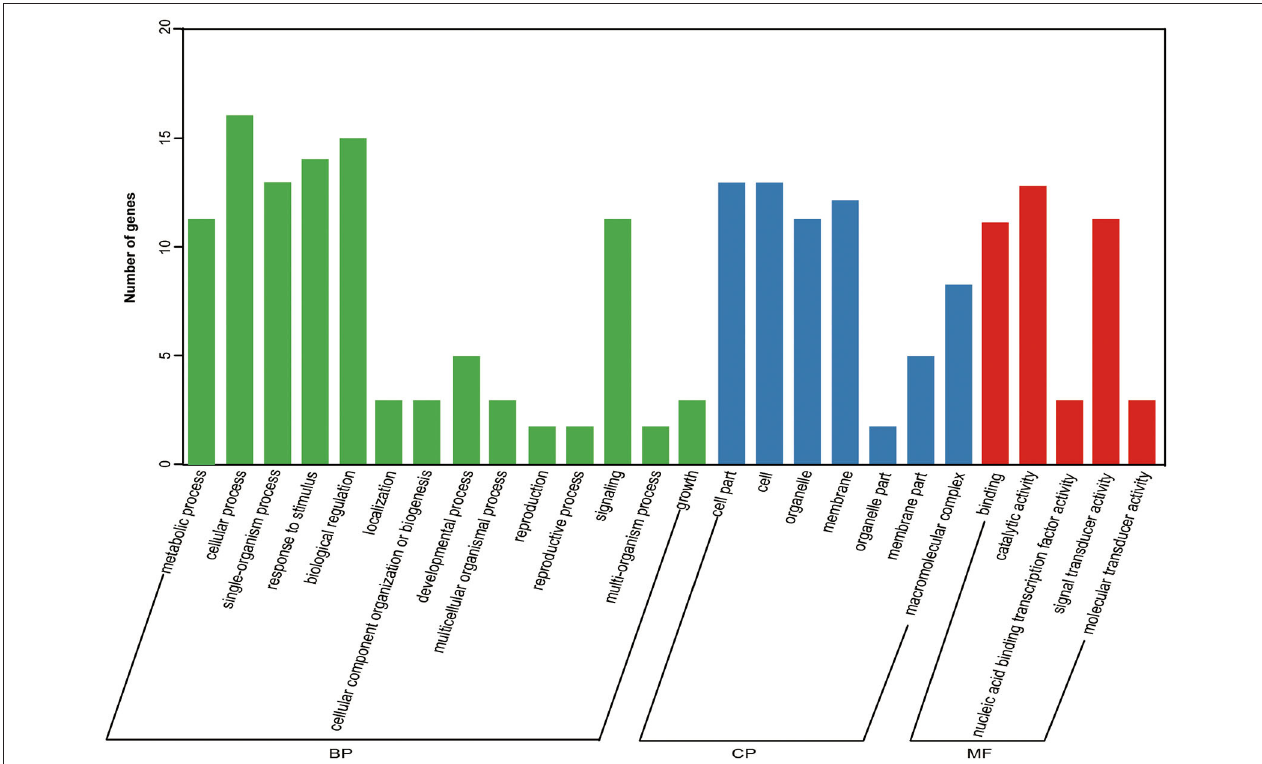
FIGURE 3 | Gene ontology (GO) enrichment analysis of 31 hormone DEGs. BP, biological processes; CP, cellular compartments; MF, molecular functions.